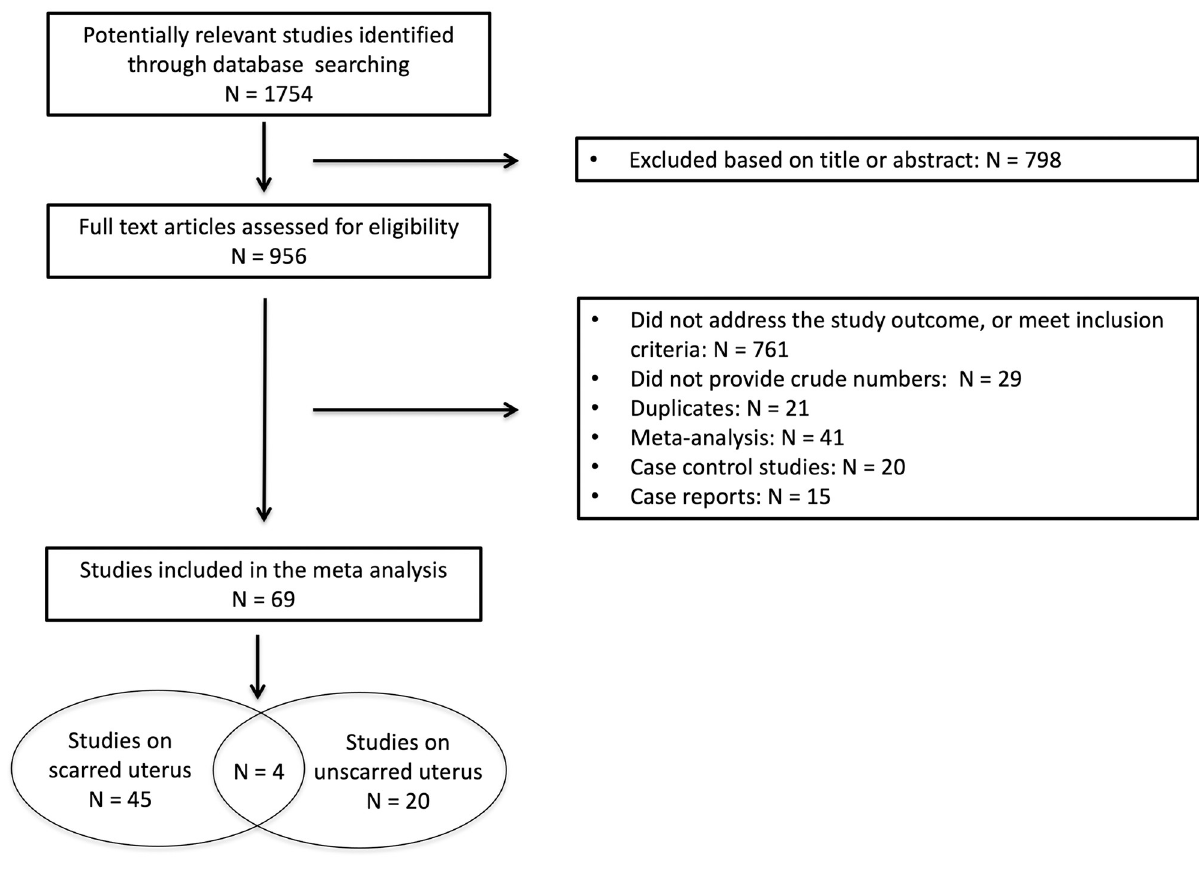
Fig 1. Flow diagram of the included